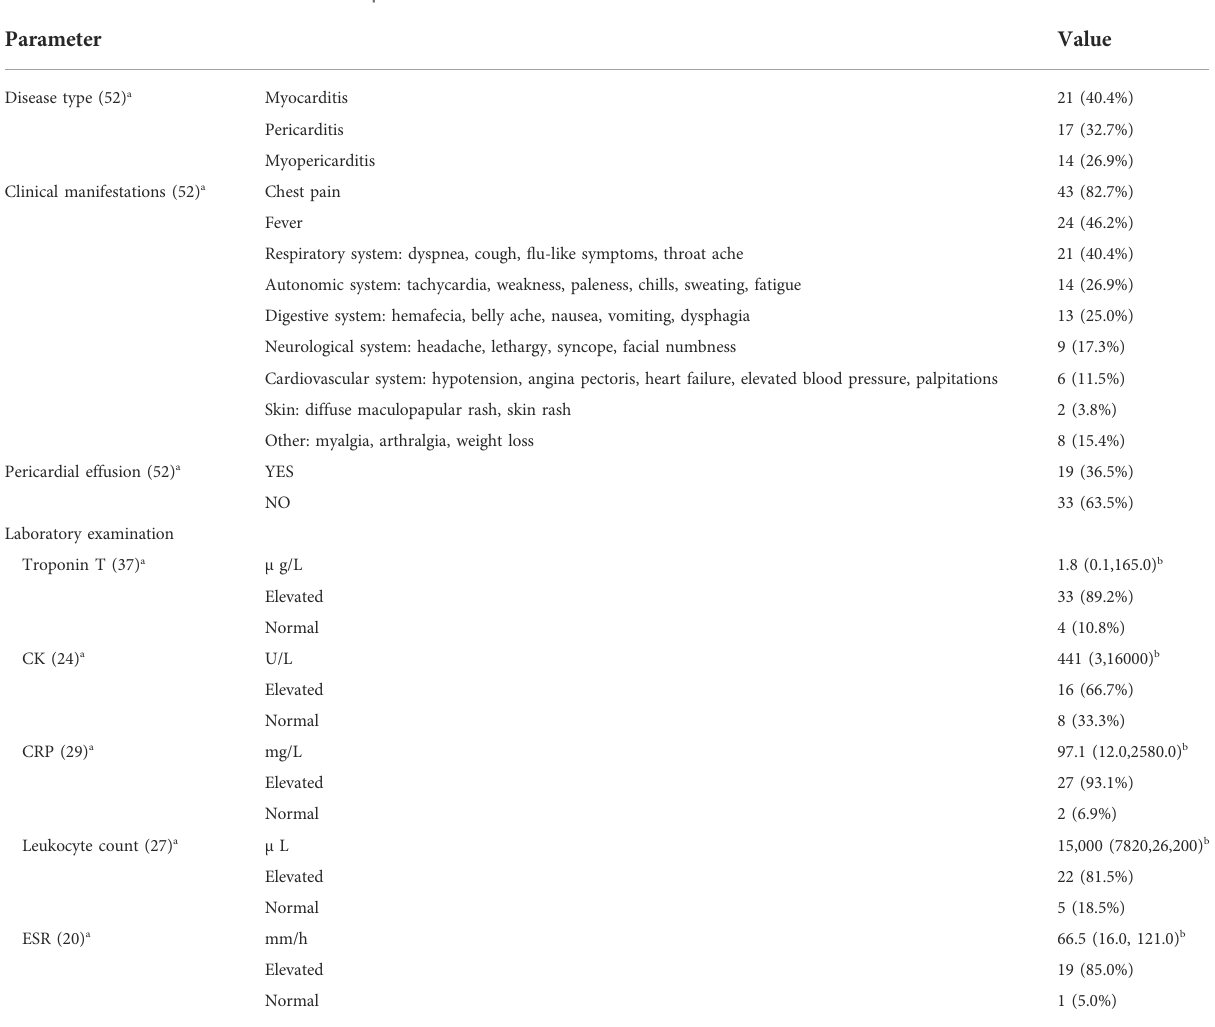
TABLE 2 Clinical information of 52 included